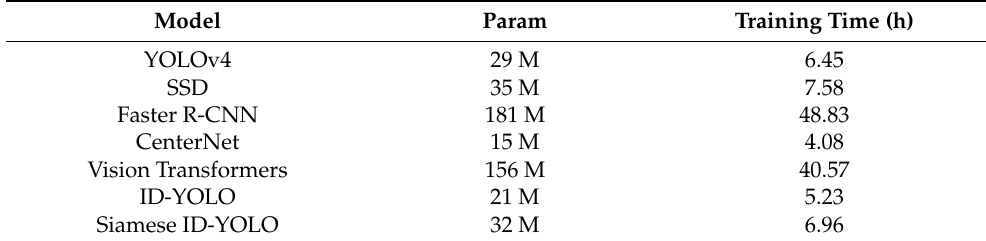
Table 10. Comparison table of computation cost and training time of different